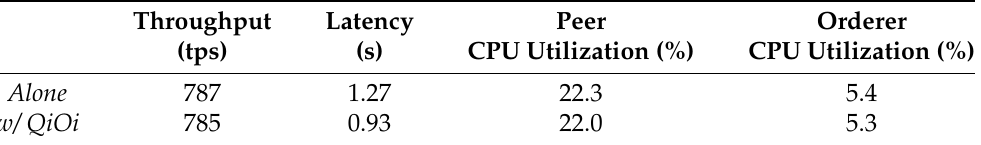
Table 5. Comparison of Fabric performance and average CPU